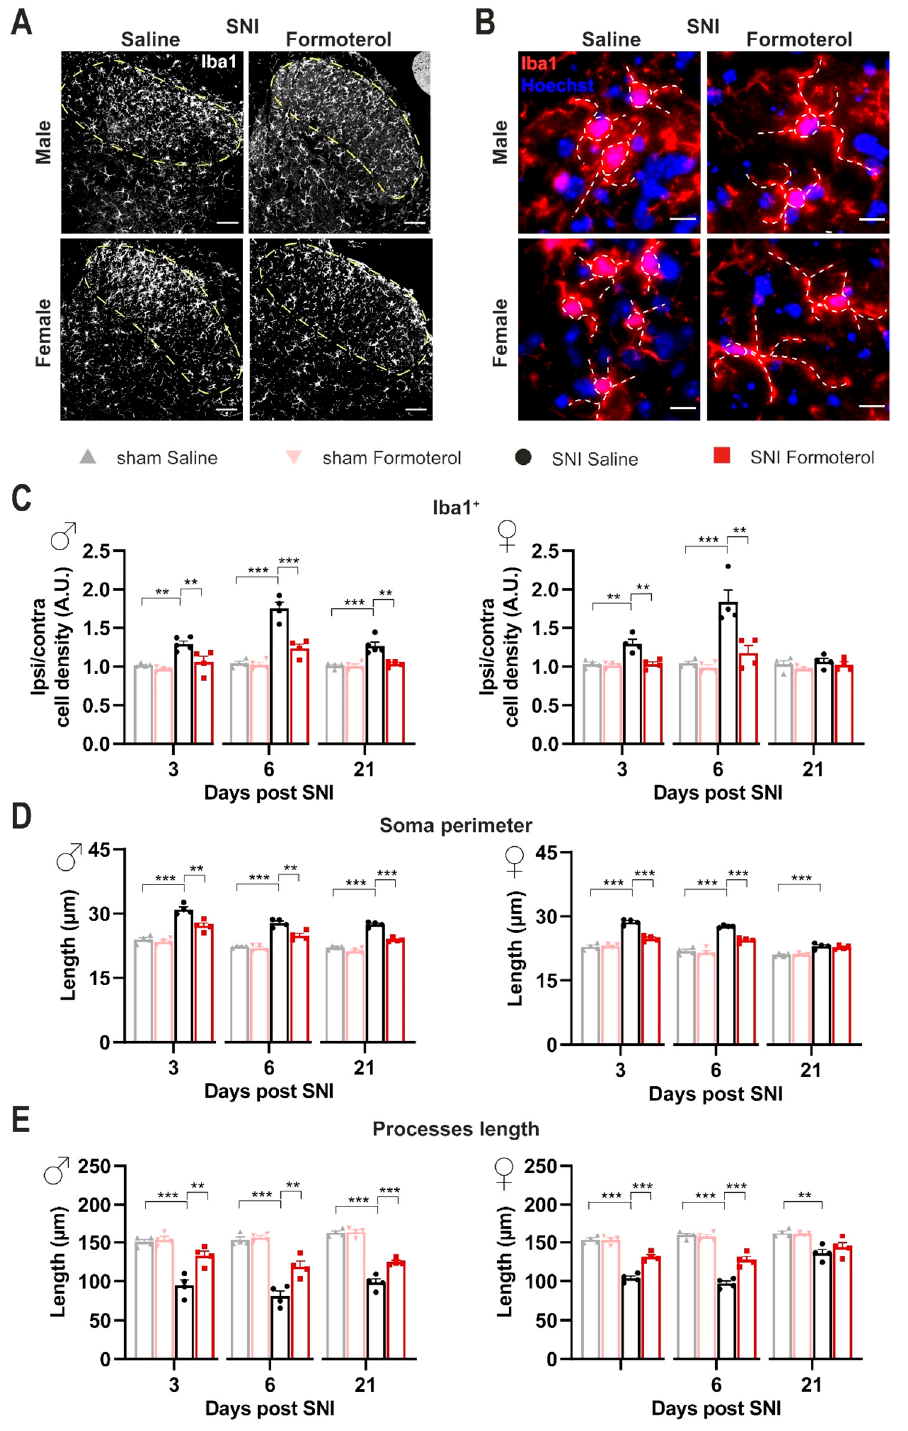
Figure 3. β 2-AR agonist diminishes microgliosis in the spinal dorsal horn of SNI-operated mice. ( A ) Typical examples of Iba1-positive cells in the ipsilateral spinal dorsal horn (SDH) of male or female mice six days after the SNI surgery, injected with saline or Formoterol. Scale bar = 60 µ m. ( B ) Representative examples of microglia (Iba1-positive with Hoechst counterstaining for cell nuclei) in the ipsilateral SDH, with somata and processes marked by white, dashed lines, six days after SNI operation injected with saline or Formoterol. Scale bar = 10 µ m. ( C ) Analysis of cell density of Iba-1 positive microglia of males (left; day 3: F1, 13 = 4.350, p = 0.0573; day 6: F1, 12 = 22.62, p = 0.0005; day 21: F1, 13 = 10.86, p = 0.0058) and female (right, day 3: F1, 12 = 11.05, p = 0.0061; day 6: F1, 12 =